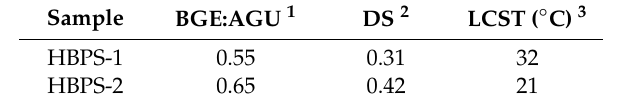
Table 1. Description of the two di ff erent starch derivative hydrogels prepared in this work. Sample